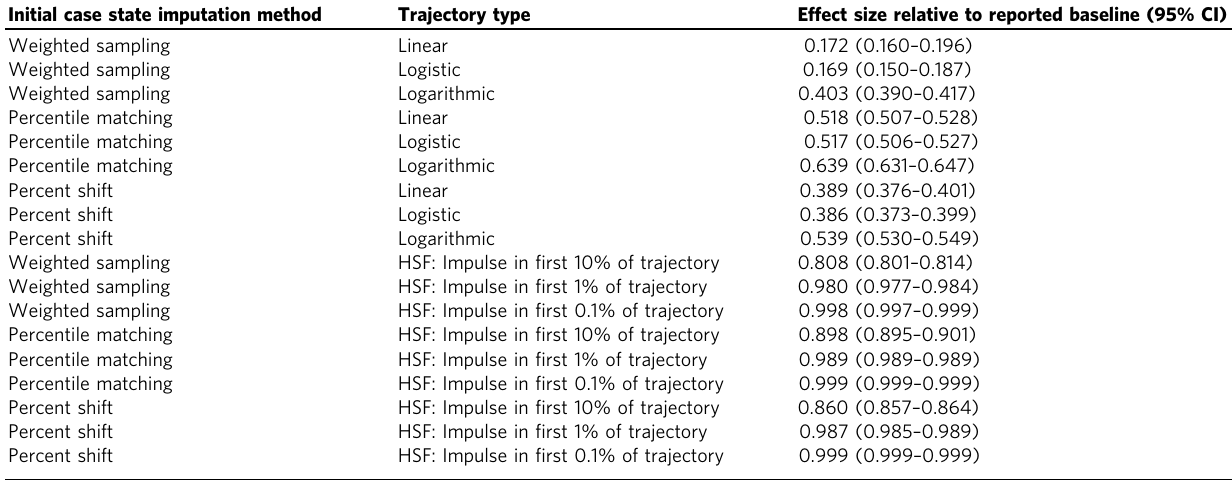
Table 1 The observed Lp(A)-MI association is magni fi ed by temporal